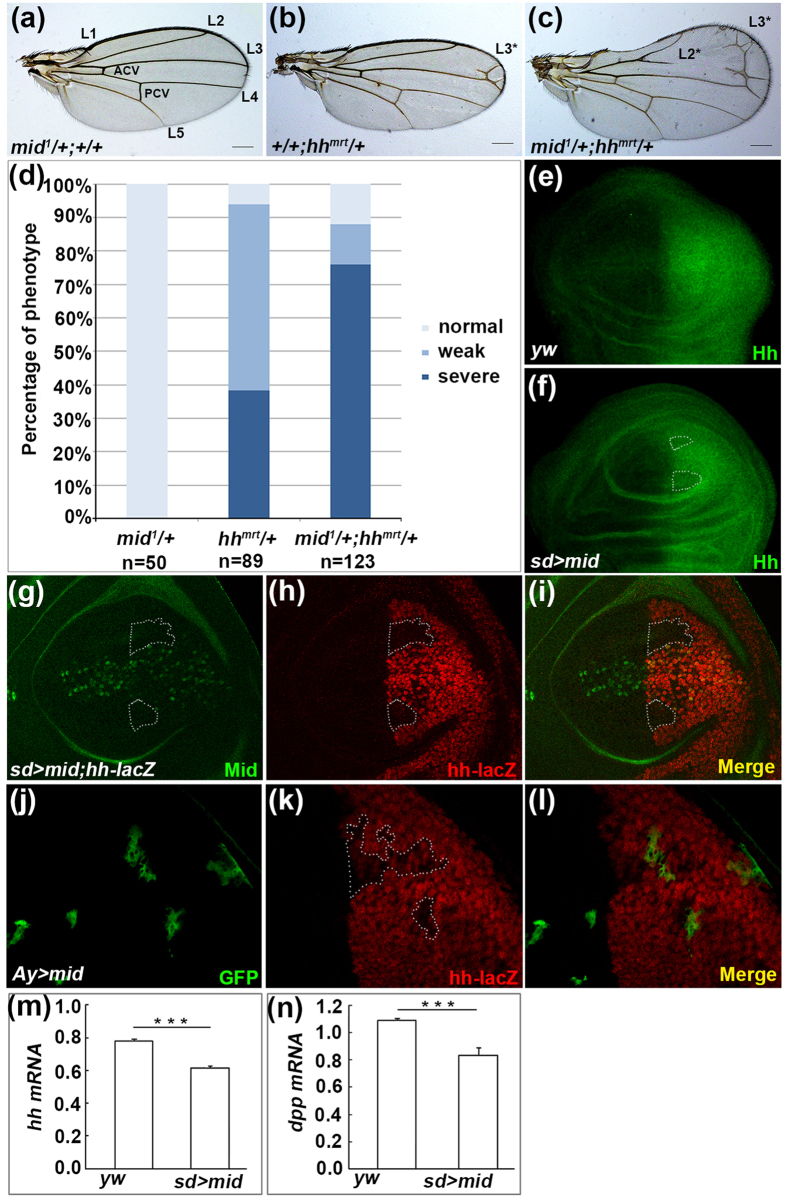
Mid represses the expression of hh.(a–c) Genetic interaction between mid and hh. Adult wings of mid1/+; +/+ (a) /+; hhmrt/+ (b) and mid1/+; hhmrt/+ (c). Note ectopic vein L3 (L3*) in (b) and ectopic veins L2 (L2*) and L3 (L3*) with enlarged anterior compartment in (c). Scale bars: 200 μm. (d) Percentage of the phenotype in (a–c). (e,f) The wing discs of wild type and sd > mid are stained with the anti-Hh antibody. The expression of Hh is repressed upon overexpression of mid (marked by broken lines in (f)). (g–i) The wing disc of sd-Gal4;UAS-mid;hh-lacZ is stained with the β-gal antibody. The expression of hh-lacZ reporter is repressed (marked by broken lines). (j–l) Somatic clone overexpressing Mid display downregulation of Hh (marked by broken lines). The wing disc from a third instar larva of hs-FLP; UAS-mid;hh-lacZ/act > y + > gal4; UAS-GFP is stained with anti-GFP antibody (j), β-gal antibody (k). (l) Merged image of (j,k). (m,n) qPCR analyses of the hh and dpp mRNA levels in yw and sd > mid.